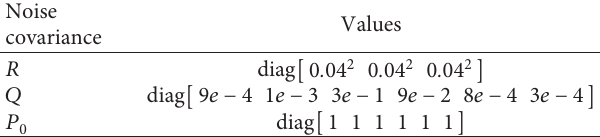
Table 3: Values of the noise.